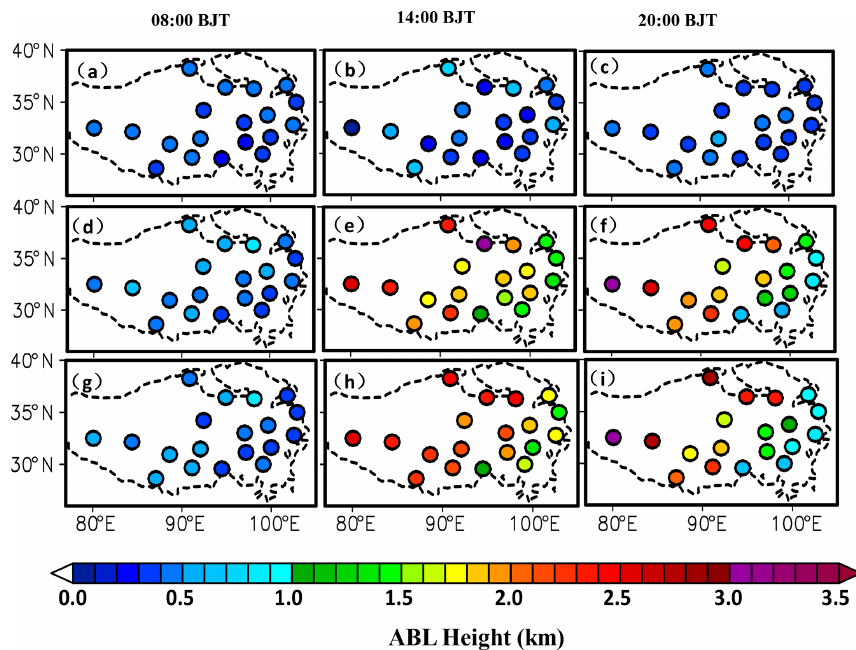
Figure 7. Spatial distributions of the mean ABLH for the SBL (a–c) , NBL (d–f) , and CBL (g–i) at 08:00, 14:00, and 20:00BJT.